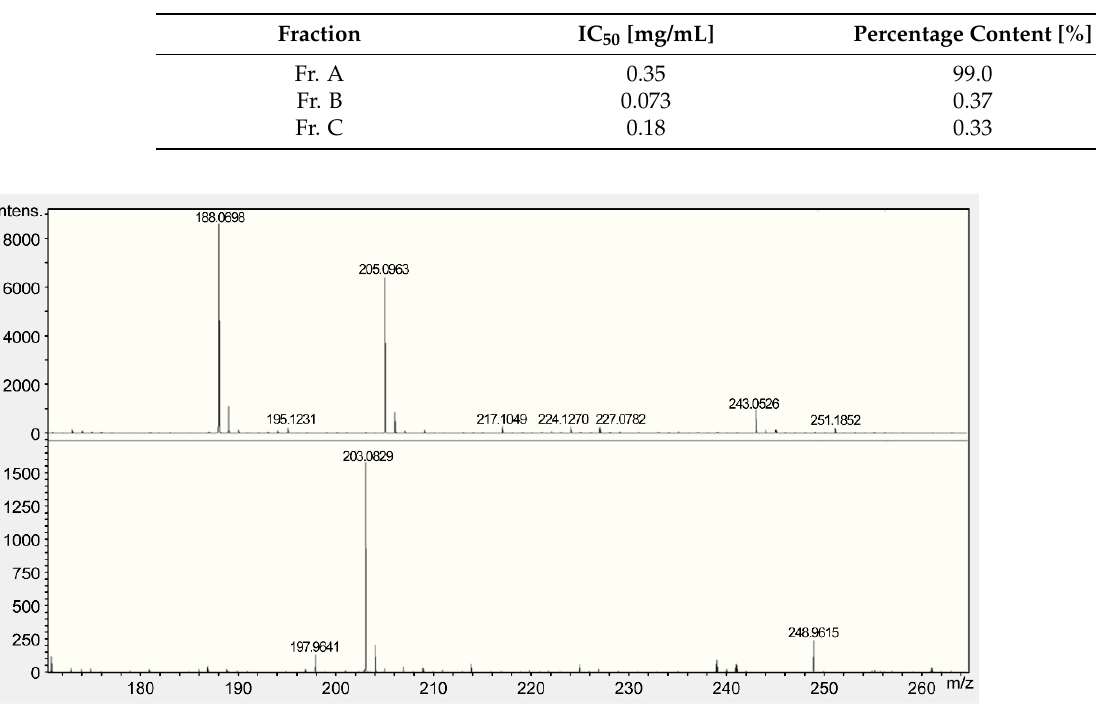
Figure 5. Nuclear magnetic resonance (NMR) spectra of D-tryptophan (Trp). (( A ): 1 H NMR, ( B ): 13 C NMR, ( C ): 1 H– 1 H COSY, ( D ): HSQC, ( E ): HMBC).